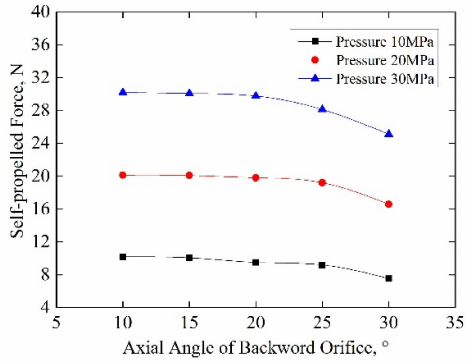
Figure 13. Graph showing the relationship between the self-propelling force and the axial angle of the backward orifices.